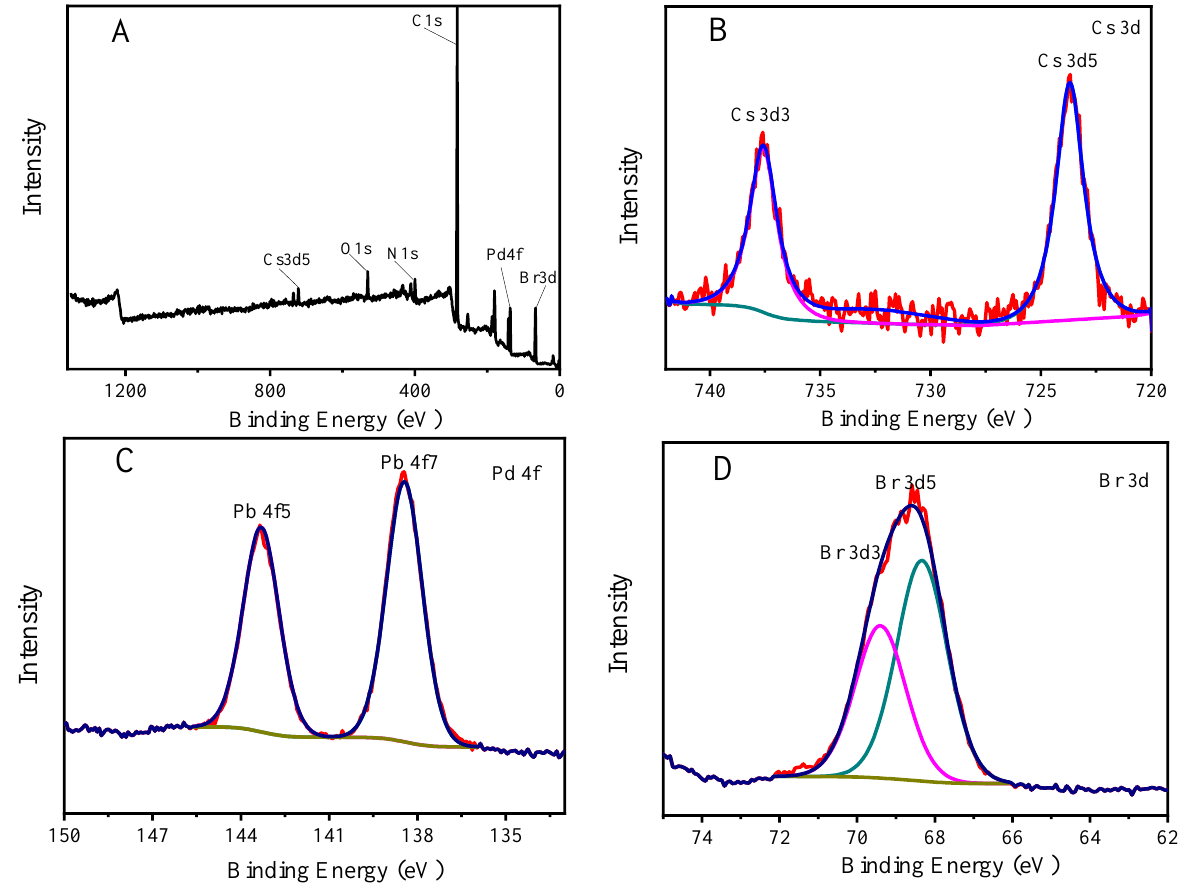
Figure 3. X-ray photoelectron spectra of CsPbBr 3 /Cs 4 PbBr 6 PNCs ( A – D ). Experimental conditions: synthetic precursors: CsBr (45.4 mM), PbBr 2 (45.4 mM), N-6-trifluoroacetyl-L-lysine (4.54 mM), reaction time: 2.5 h, reaction temperature: − 18 °C. Synthesis of CsPbBr 3 /Cs 4 PbBr 6 PNCs: OLA (250 μL), precursor (1.375 mL). Reaction time: 20 min, reaction temperature: 25 °C.